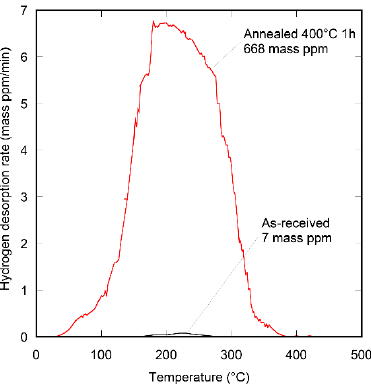
Figure 8. Hydrogen thermal desorption curves of immediately charged by hydrogen for 6 h at current density of 10 A/m 2 and aged for 24 h at room temperature.